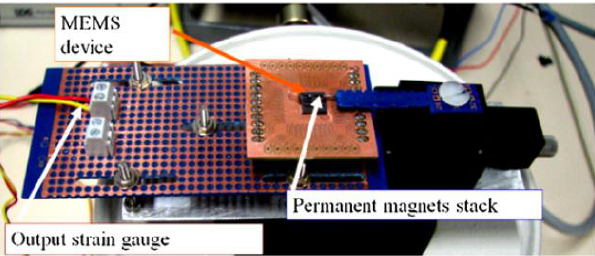
Figure 22. MEMS nonlinear oscillator [96] ( © IOP Publishing. Reproduced by permission of IOP